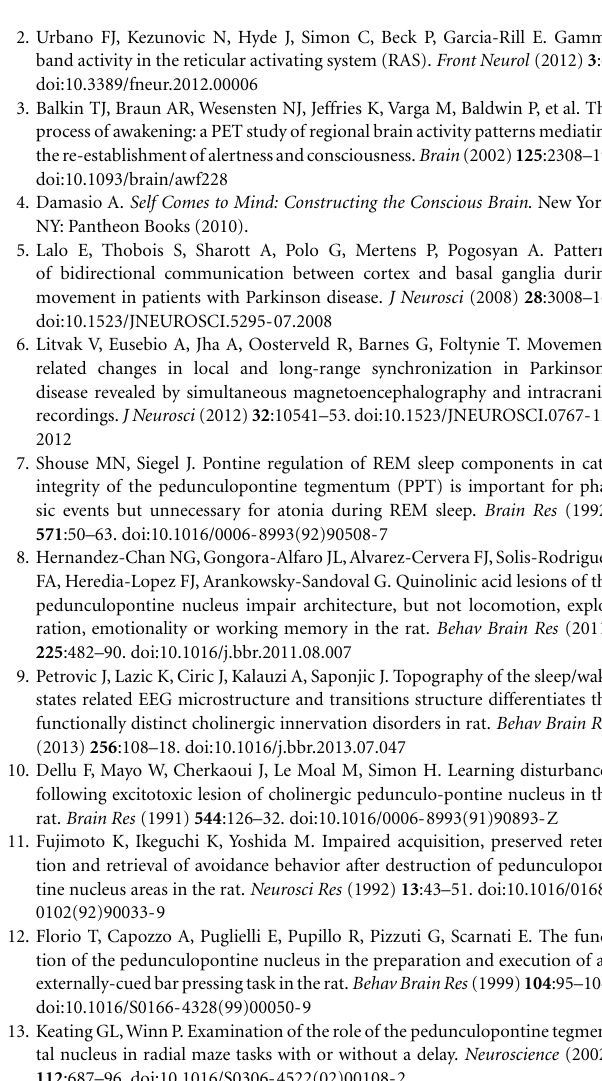
FIGURE 4 | Natural frequency of PPN population . Event related spectral perturbations (ERSPs) calculated after loading the slice with the voltage-sensitive dye ANEPPS. In order to increase background activity, carbachol (CAR) was perfused (30 µ M) and the slice stimulated using a bipolar electrode inserted at the posterior edge of the PPN.The ERSPs represent a rolling power spectrum over time after delivery of the stimulus